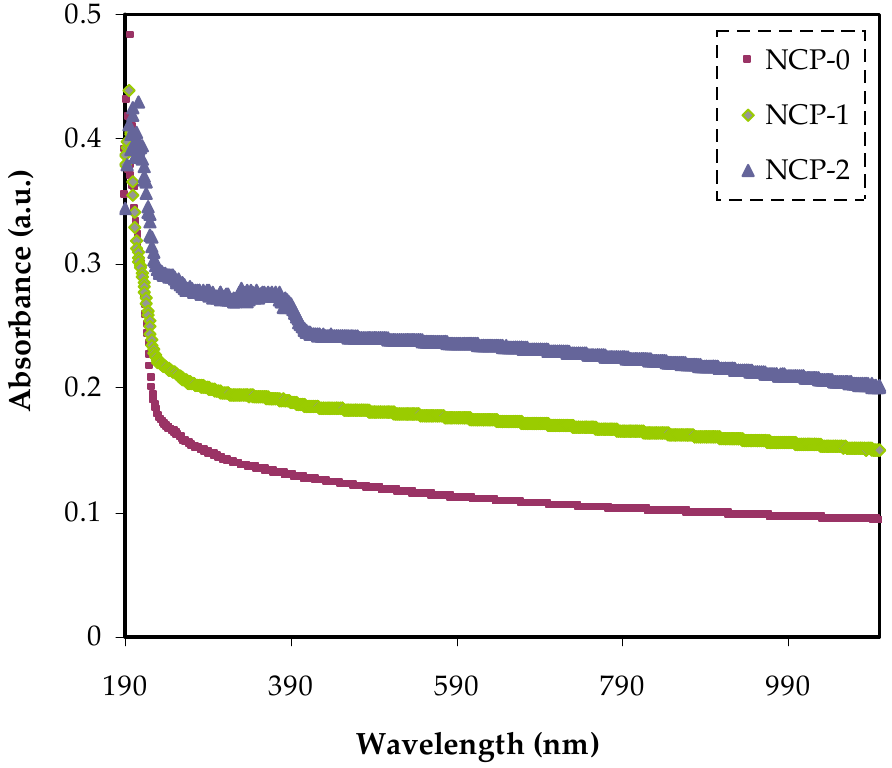
Figure 3. Absorption spectra of NCP-0 and composite samples.